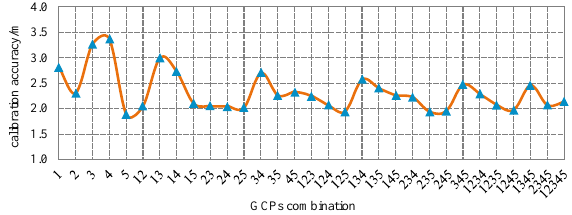
Figure 5. Accuracy evaluation of different GCP